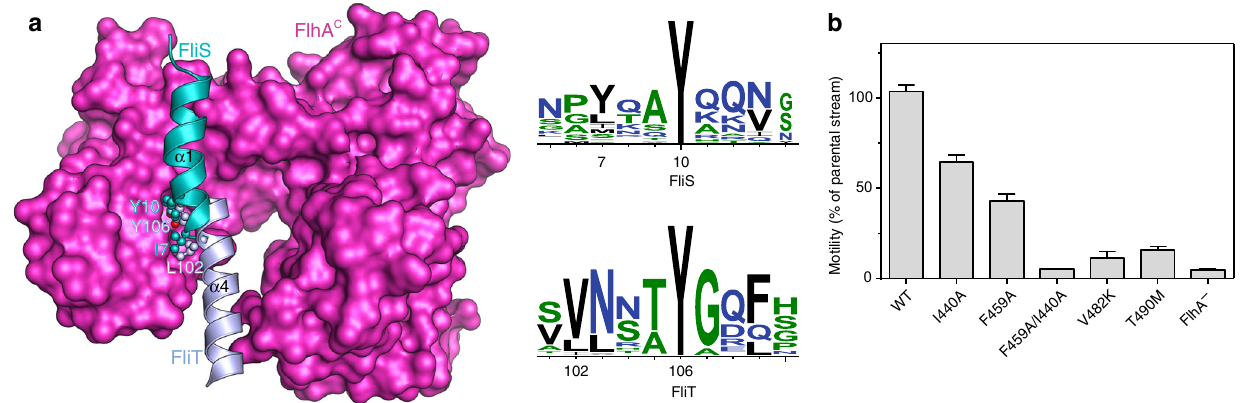
Fig. 5 Recognition mechanisms and functional importance of the FlhA ternary complexes. a Superposition of the two ternary complexes (FlhA C − FliT − FliD C and FlhA C − FliS − FliC C ) on FlhA C . For clarity only the recognition helices are shown (FliT helix α 4 and FliS helix α 1). The two key residues recognized by FlhA is a Tyr (Tyr106 in FliT and Tyr10 in FliS) and a hydrophobic one (Leu102 in FliT and Ile7 in FliS). Sequence conservation of the recognition helices in FliT and FliS is also shown. b Effect of amino acid substitutions at the binding interface on the kinetics of bacterial motility. Bar graphs represent the mean value of the colony diameter and error bars represent standard deviation ( n =